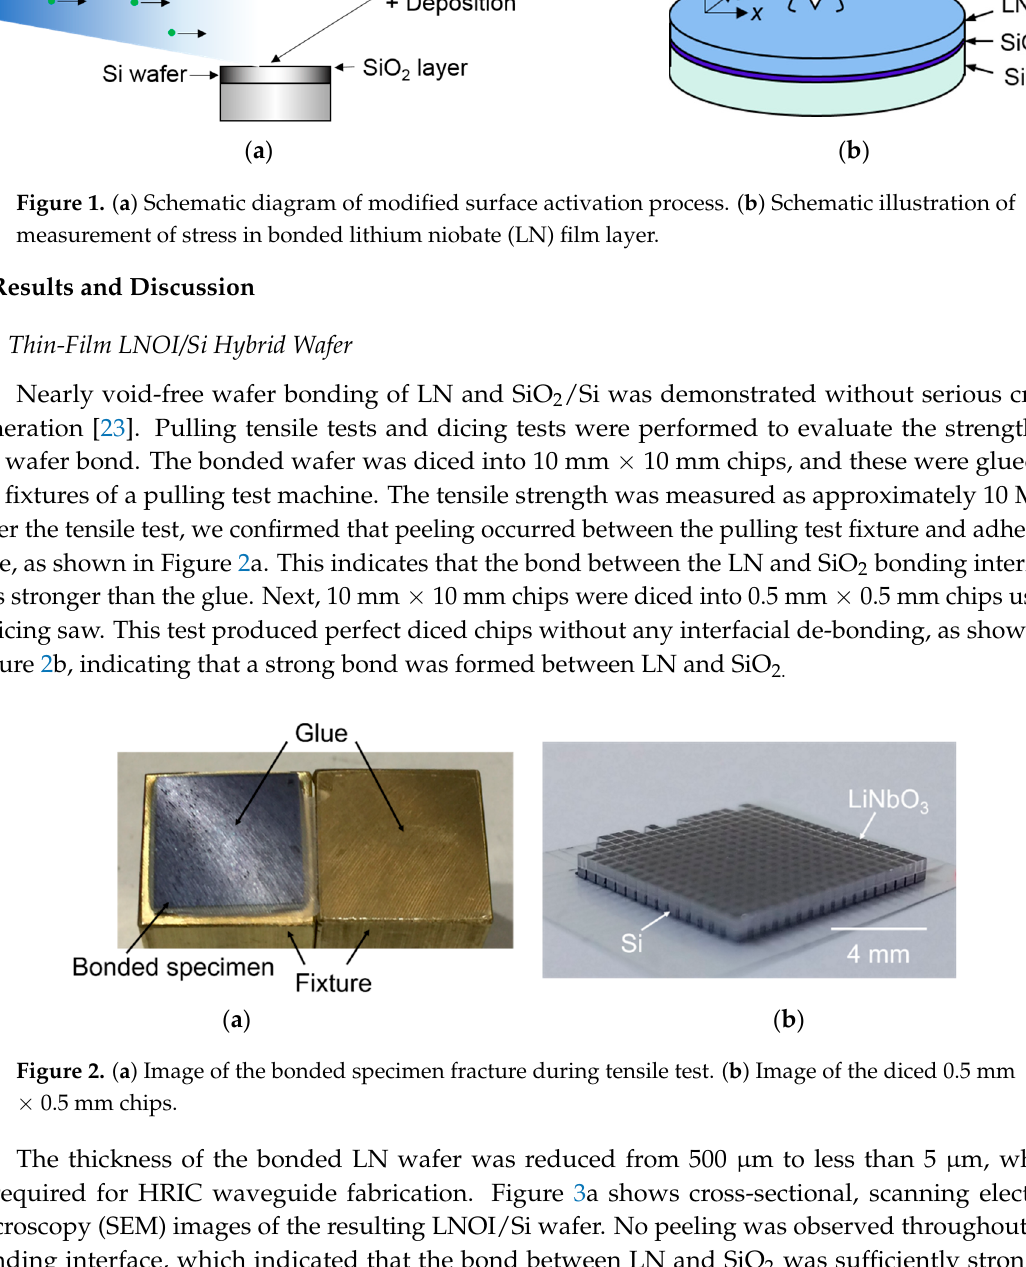
Figure 2. ( a ) Image of the bonded specimen fracture during tensile test. ( b ) Image of the diced 0.5 mm × 0.5 mm